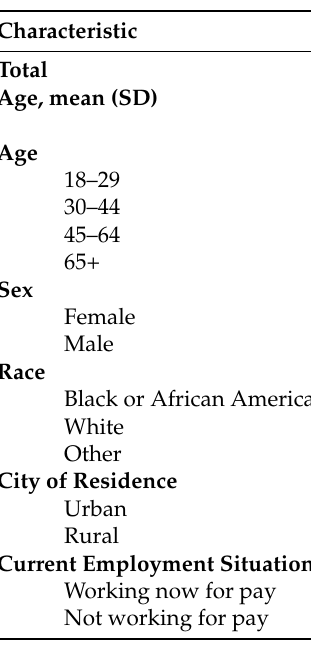
Table 1. Demographic Characteristics of Participants ( n =